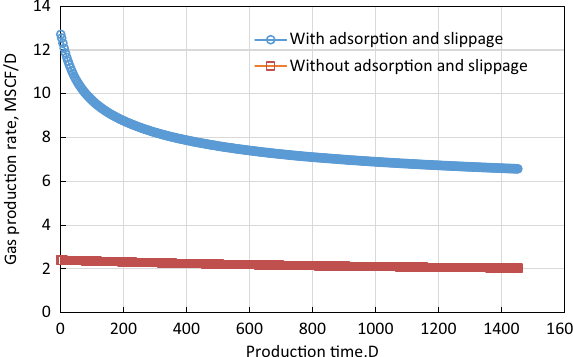
Fig. 5 Combination effects of gas adsorption and gas slippage on the performance of shale gas